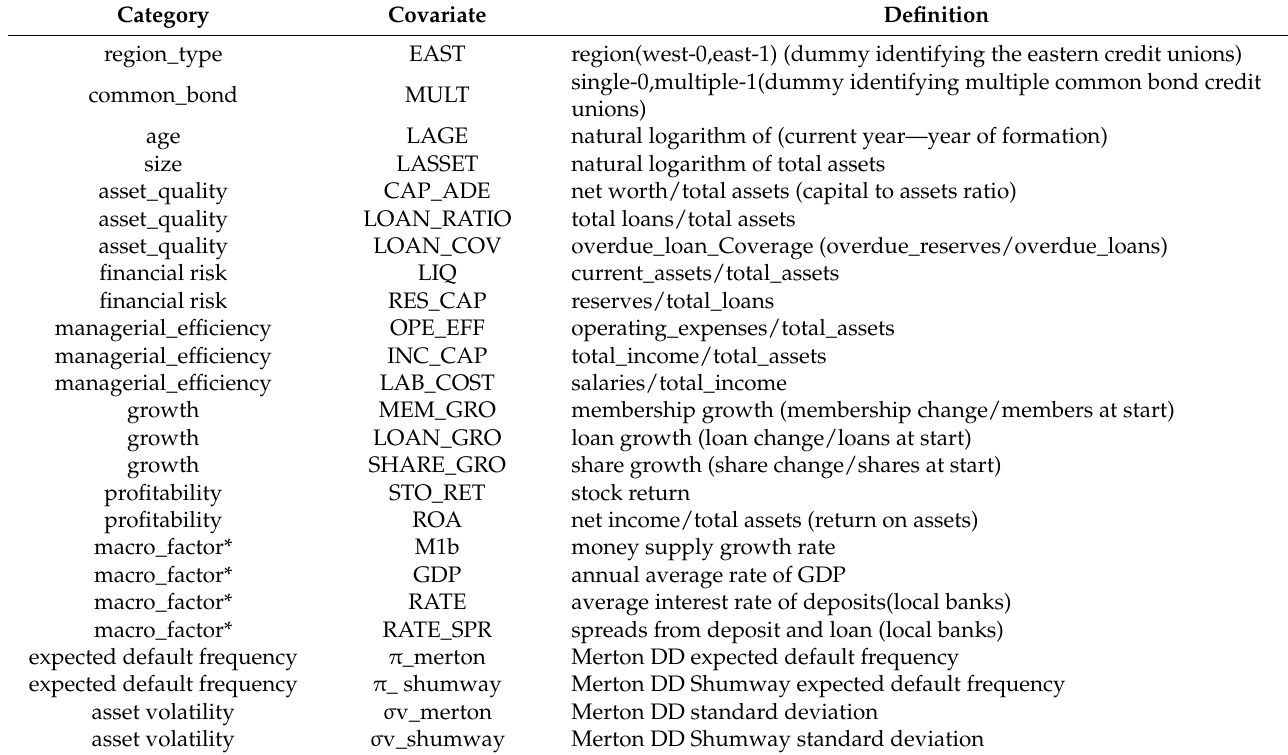
Table 1. Covariates